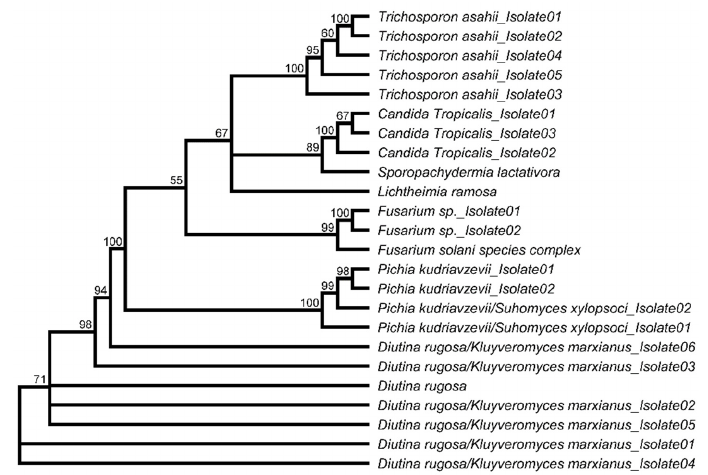
Figure 4. Phylogenetic analysis of all fungal BSF gut isolates based on 5.8S-ITS sequences. Unrooted neighbor-joining tree using the JC69 Jukes and Cantor substitution model. The numbers indicate support for clade branching (%) of 1000 bootstrap replications.